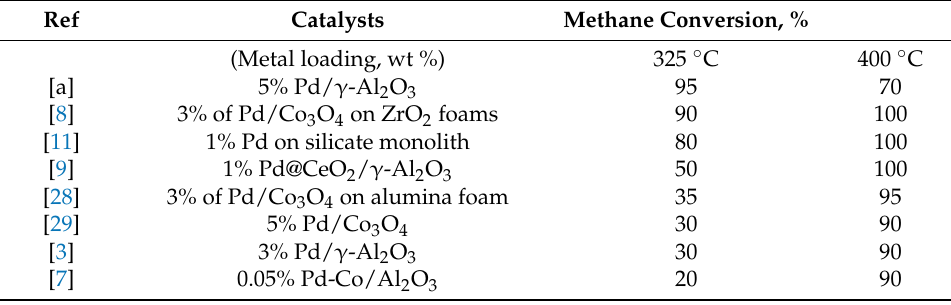
Table 2. Review of recent literature on catalytic activity for methane combustion.